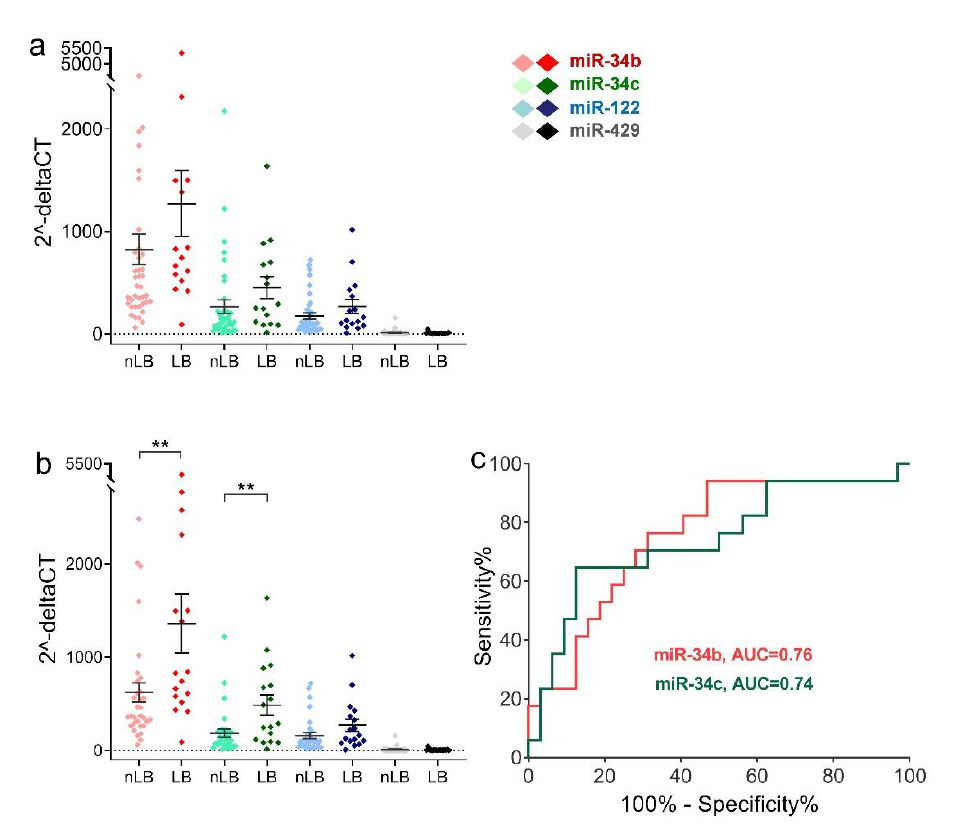
Figure 5. Relative expression levels of miRNAs in male factor sperm and teratozoospermic sperm in live birth and non-live birth groups. ( a ) Scatter plot showing sperm miRNA relative levels for each male factor patient with or without live birth. ( b ) Scatter plot showing sperm miRNA relative levels for each teratozoospermia patient with or without live birth. ( c ) ROC curve analysis of miR-34b/c. The data are shown as mean and SEM. LB, live birth; nLB, non-live birth; AUC, area under the curve. ** p < 0.01. Table 2. Comparison of sperm miR-34b levels and ICSI outcomes in men with teratozoospermia. ICSI